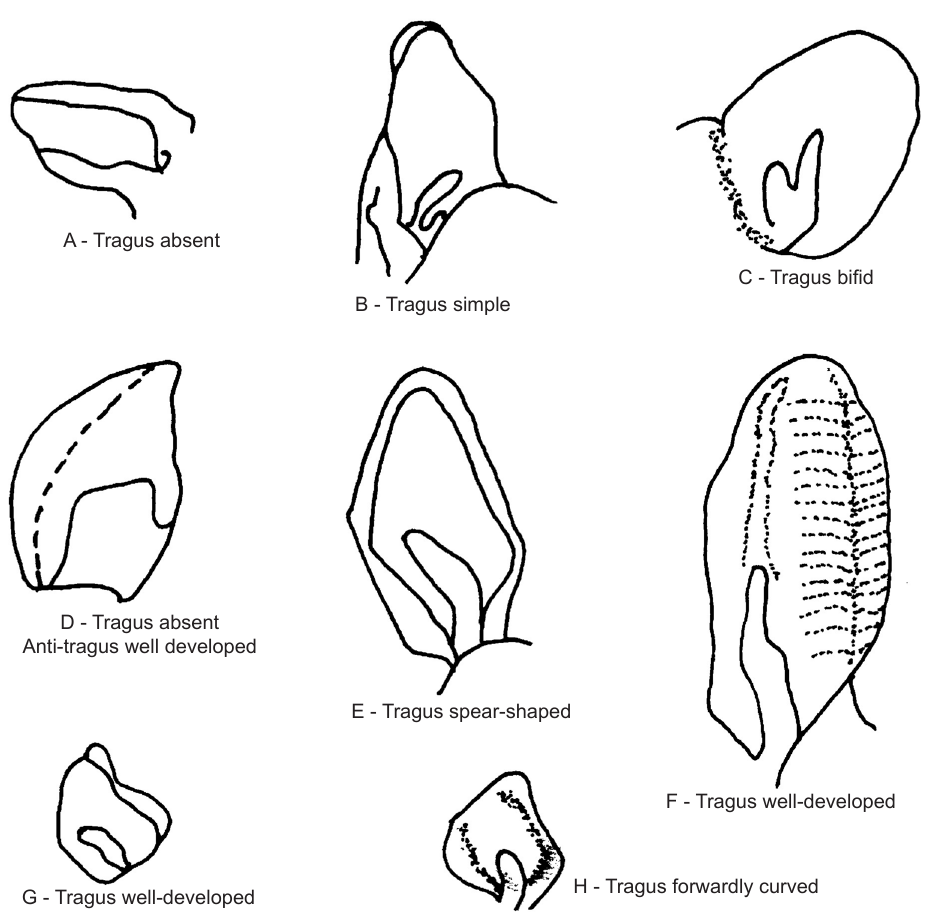
Figure 7. outline of ear and shape of tragus in select species of bats [a - Pteropus giganteus ; B - Rhinopoma microphyllum ; C - Megaderma lyra ; D - Rhinolophus luctus ; E - Myotis sp.; F - Plecotus wardi ; g - Pipistrellus pipistrellus ; h - Miniopterus schreibersii